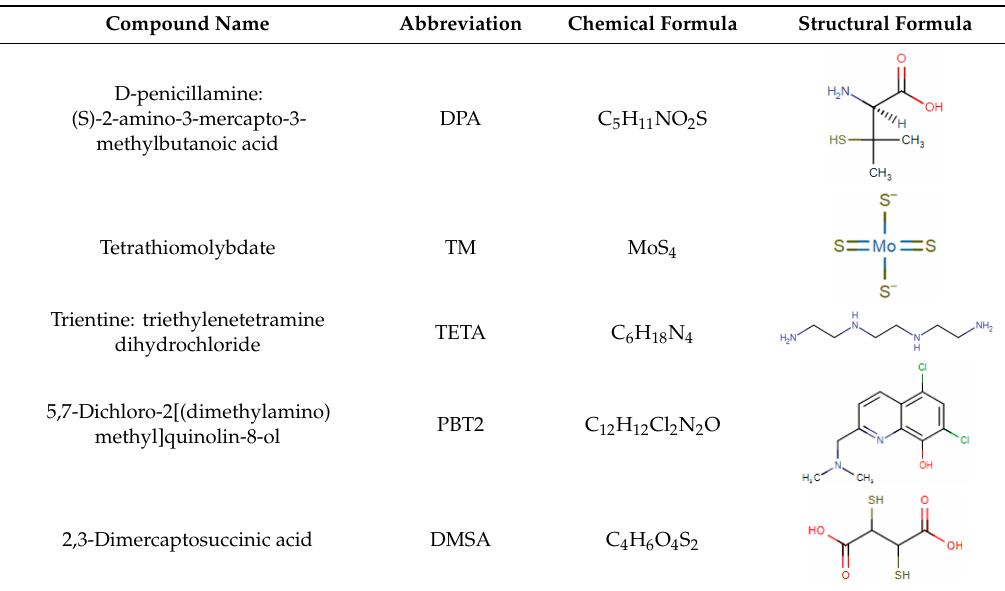
Table 1. Main copper chelating